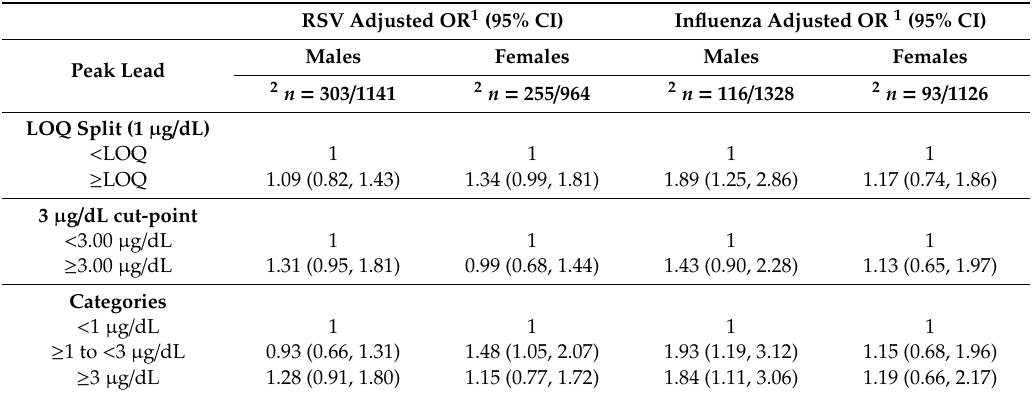
Table 5. Adjusted risk estimates of respiratory syncytial virus (RSV) and influenza comparing cases with controls by peak blood lead concentrations stratified by sex ( n =